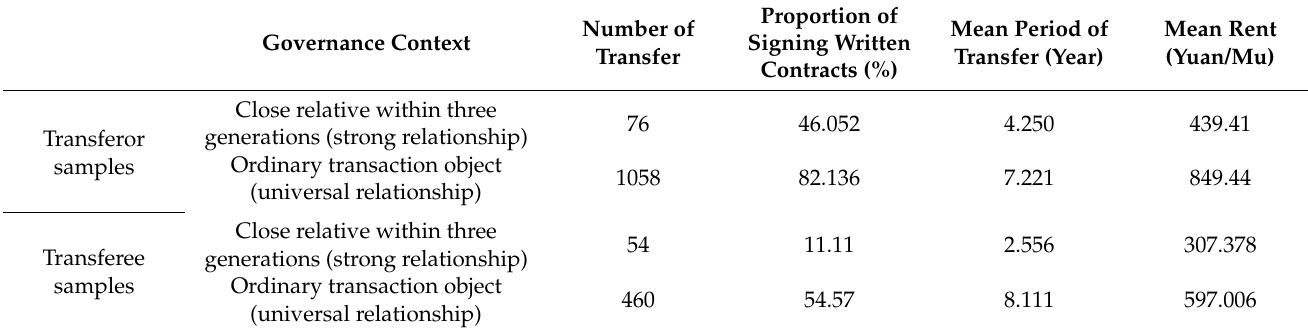
Table 2. Relationship governance and transfer